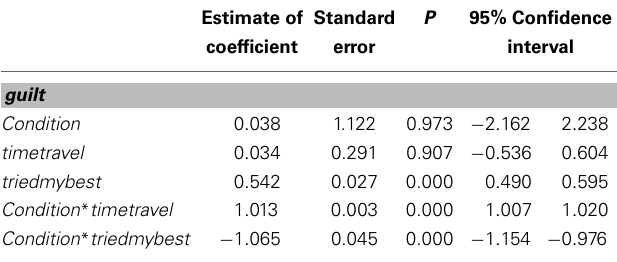
Table 6 | Ordered logistic regression for guilt , n =